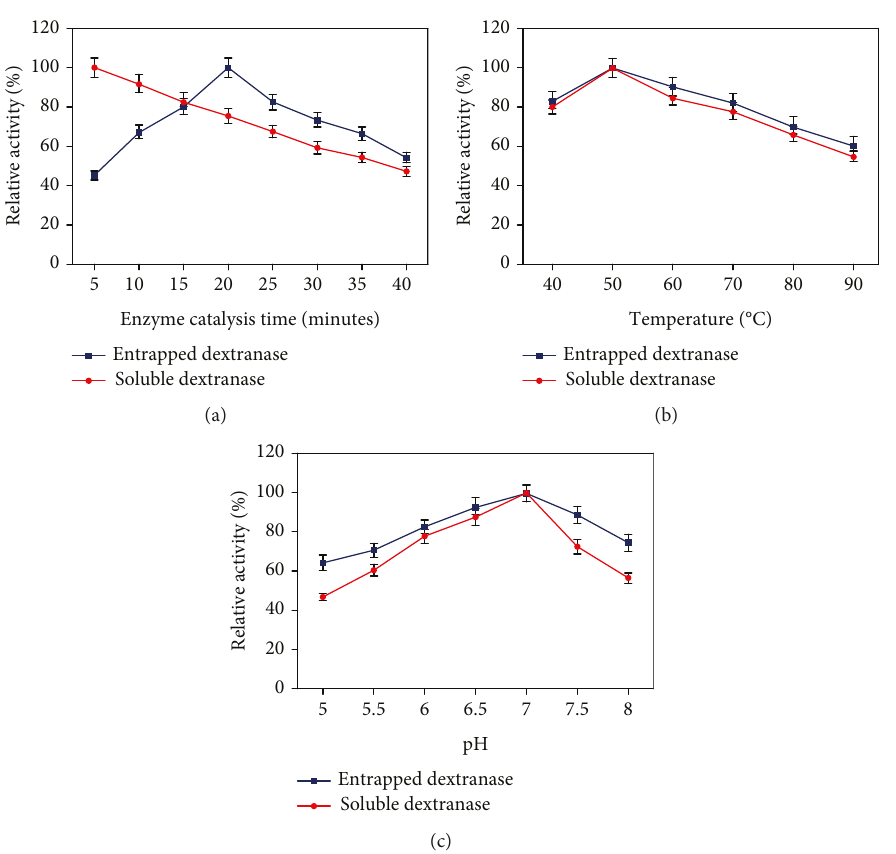
Figure 3: Comparison of characteristics of entrapped dextranase with those of the soluble enzyme: (a) e ff ect on reaction time after entrapment; (b) e ff ect of temperature on entrapped dextranase; (c) e ff ect of change in pH after entrapment in alginate spheres. All values are shown as mean of three independent experiments ( n = 3